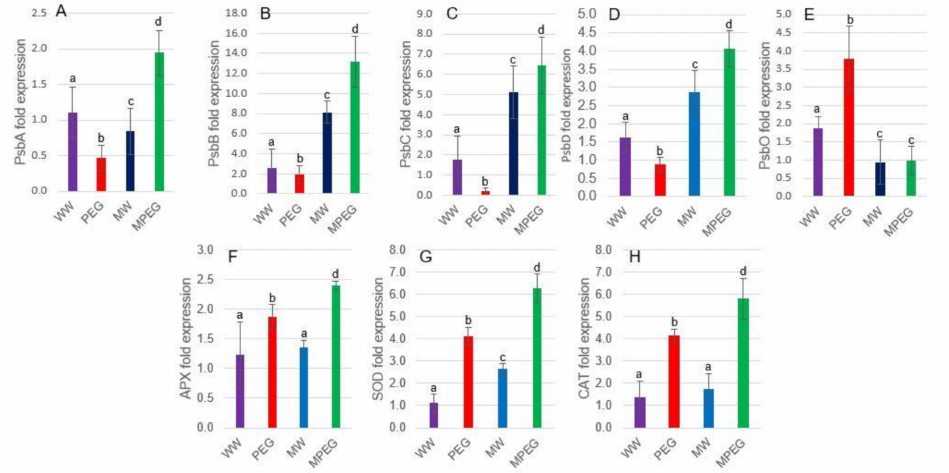
Figure 3. Real-time mRNA expression of the genes encoding ( A ) PsbA , ( B ) PsbB , ( C ) PsbC , ( D ) PsbD , ( E ) PsbO, ( F ) ascorbate peroxidase (APx), ( G ) superoxide dismutase ( SOD ), and ( H ) catalase ( CAT ). Fold expression values are normalized to those of the GAPDH control. WW, well-watered; PEG, PEG-treated oat plants; MW, Melatonin-treated, well-watered oat plants; MPEG, Melatonin-treated oat plants subjected to PEG stress. Di ff erent letters in each row indicate significant di ff erences ( p ≤ 0.05) in the relative gene expression between the treatments after performing the Tukey test ( n =